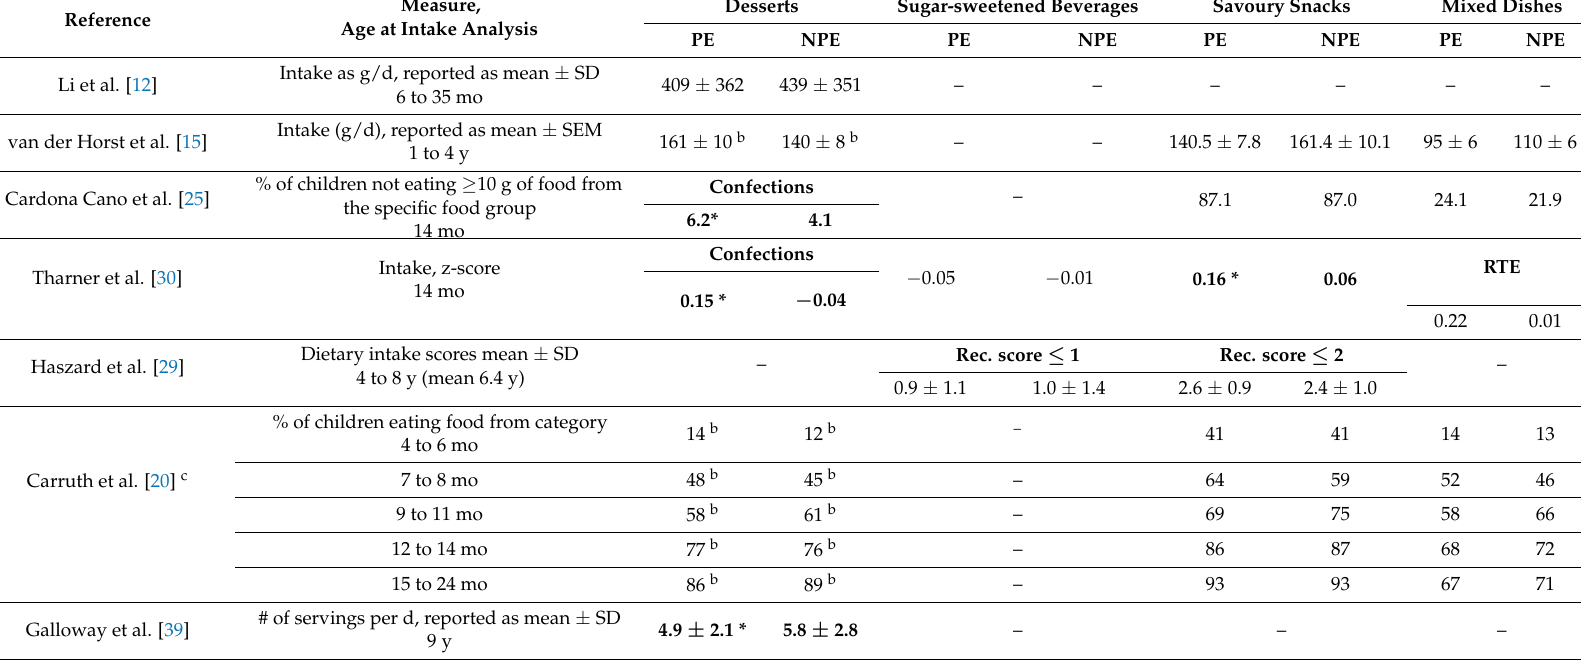
Table 3. Food Preferences Assessed as Intakes of Discretionary Foods and Mixed Dishes in PE and NPE a